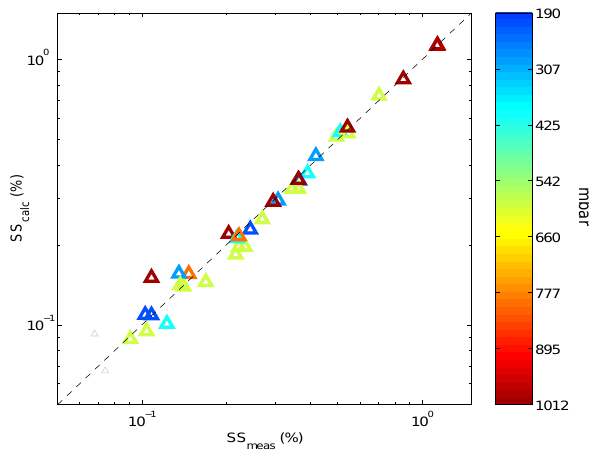
Fig. 3. Comparison of calculated and measured supersaturations based on calibrations in Fig. 2 ( r 2 =0.96). Markers are color coded for pressure at which the calibrations were